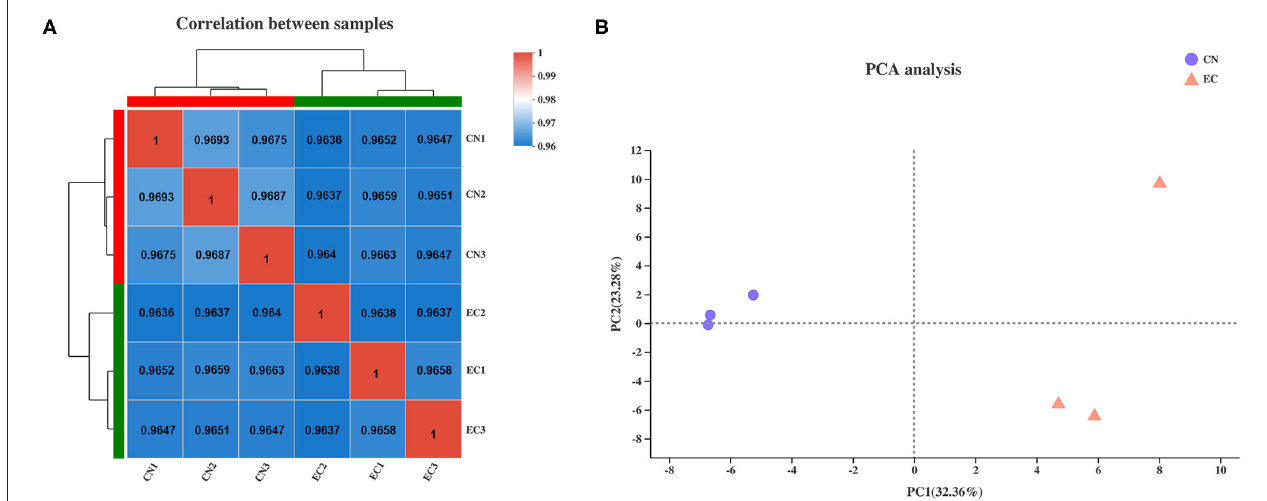
FIGURE 1 | Correlation analysis and principal component analysis of samples. (A) Heatmap of hierarchical clustering for six samples using Spearman method. Bold values represented R 2 for replicates of each sample. (B) Principal component analysis plot of samples. Each point represented one sample. Percentages were contribution ratios.